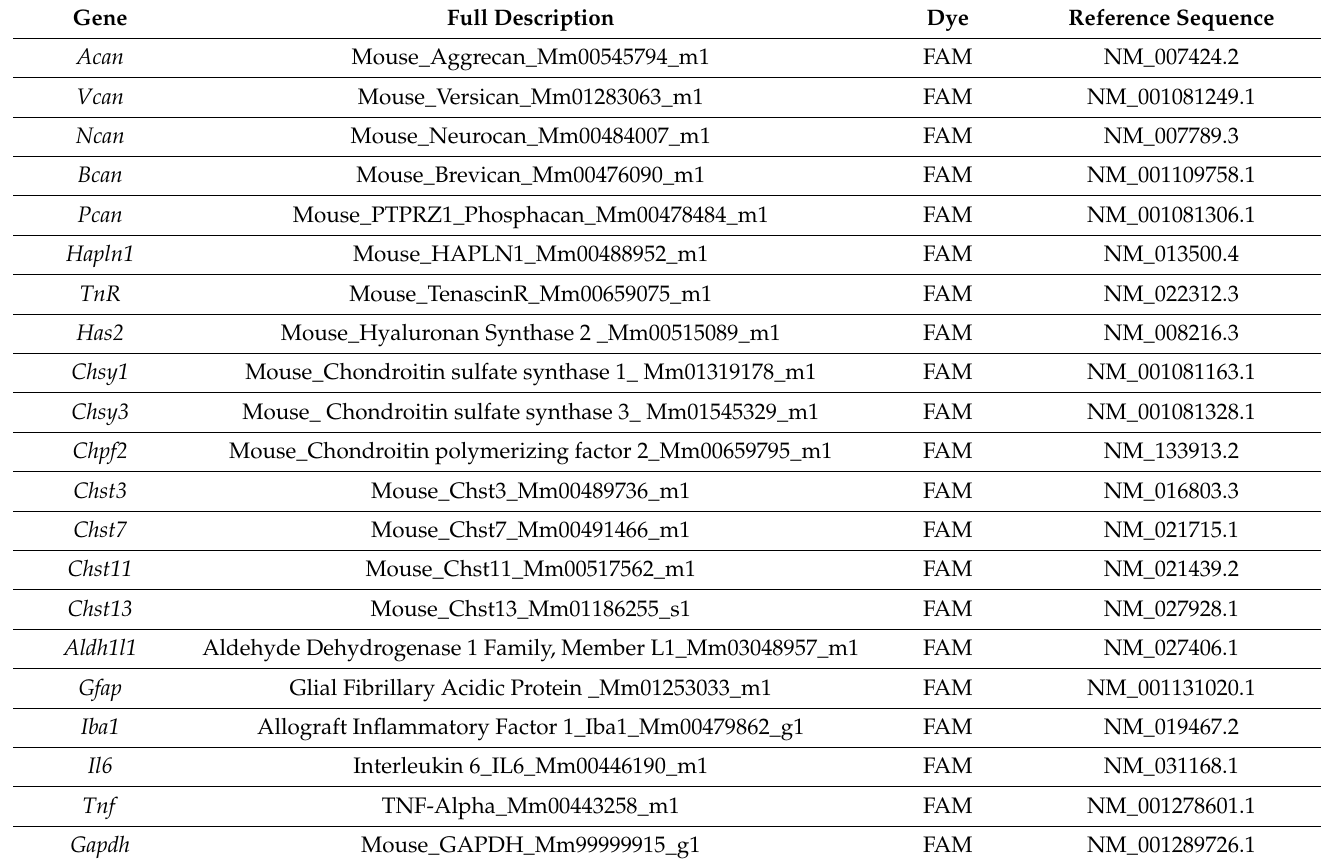
Table 1. Taqman probes used for real-time PCR